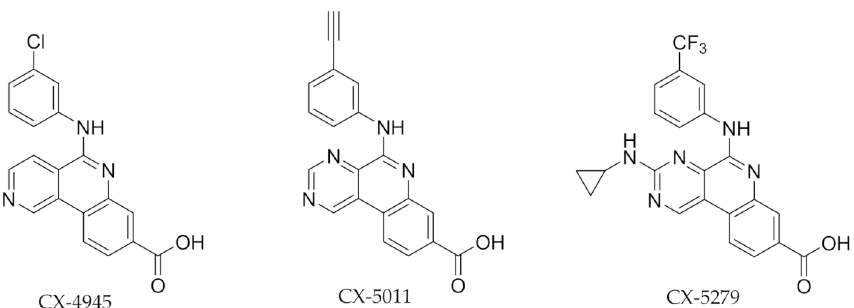
Figure 7. Structures of the improved ATP-competitive inhibitors CX-5011 and CX-5279 compared to CX-4945